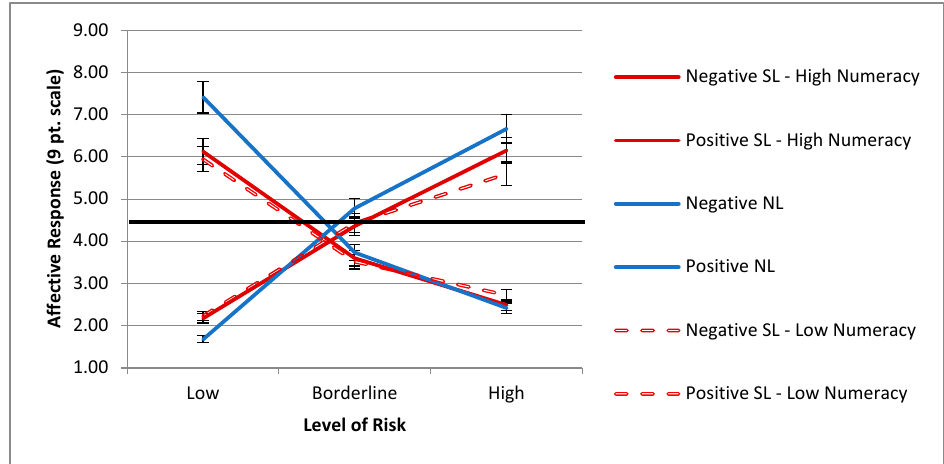
Figure 3. SL and NL Positive and Negative Affective Responses.